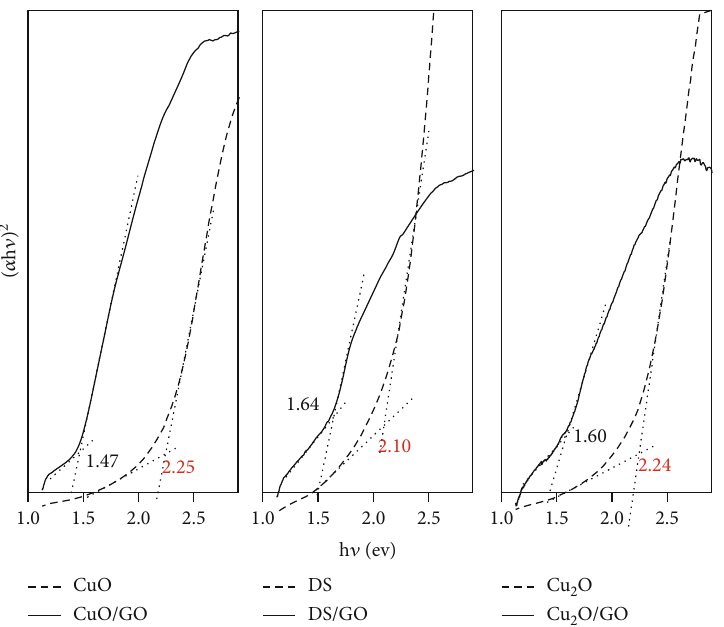
Table 3: Bandgap energy extracted from Figure 5. Catalyst